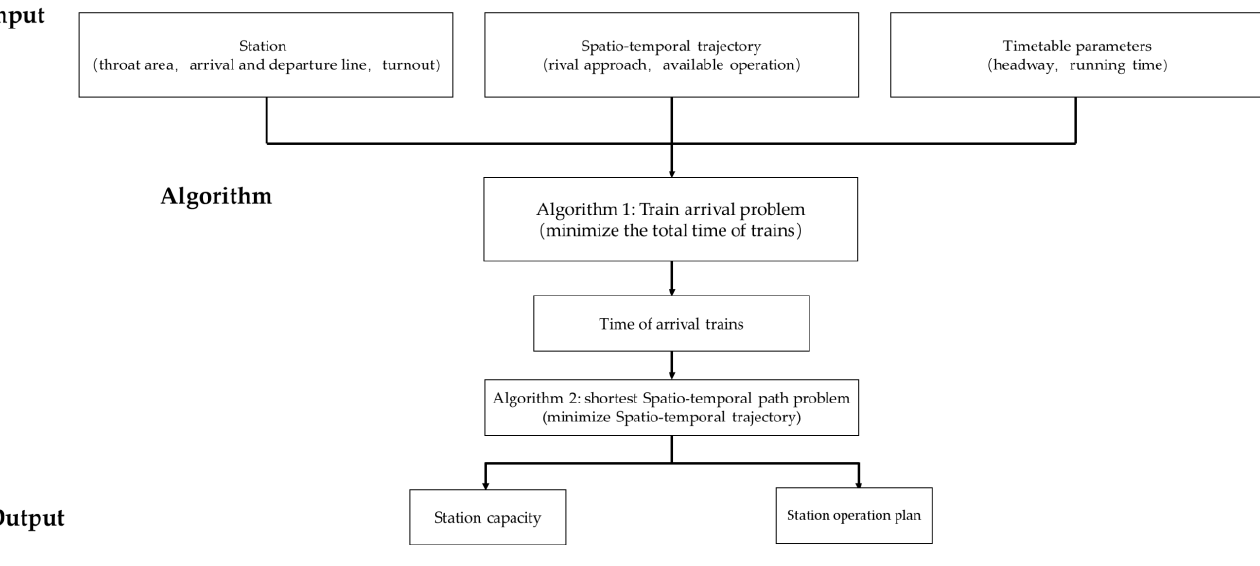
Table 1. Sets, indices, and parameters.